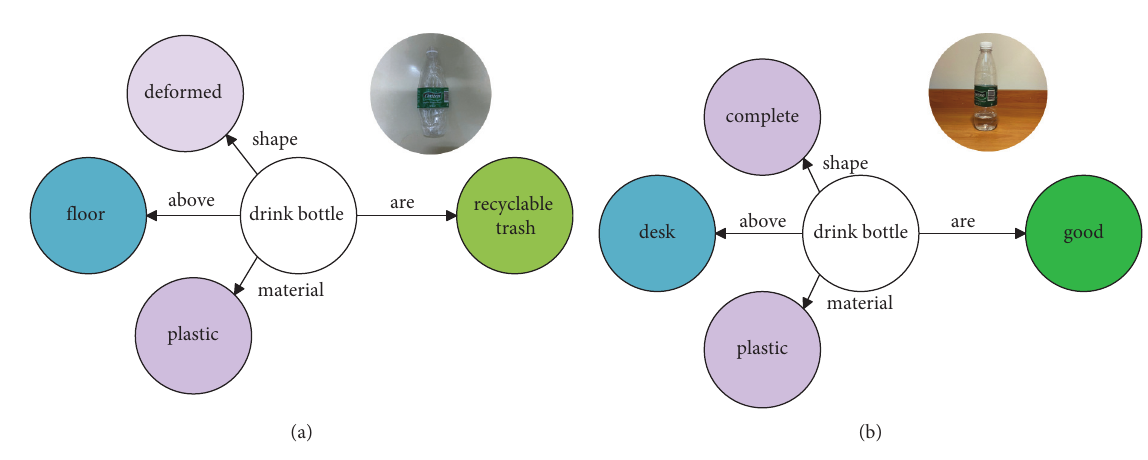
Figure 9: Comparison result graphs.